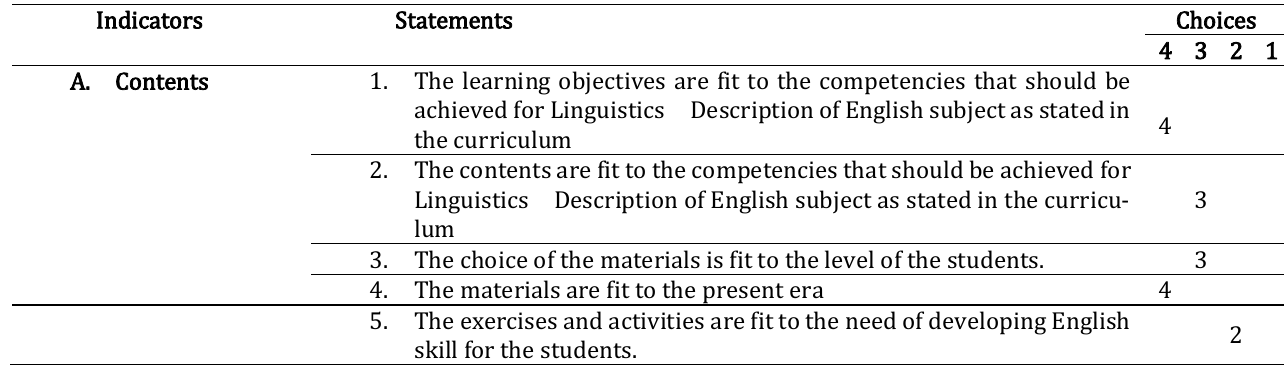
Table 2. The result of validation for the content aspect of the prototype of teaching materials for Linguistics Description of English